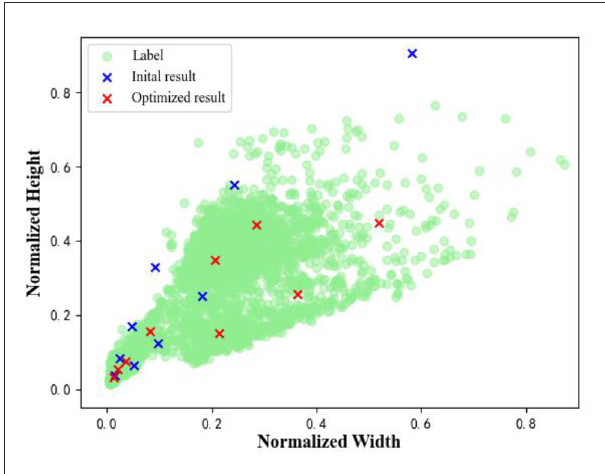
FIGURE4 The comparison of anchor size.